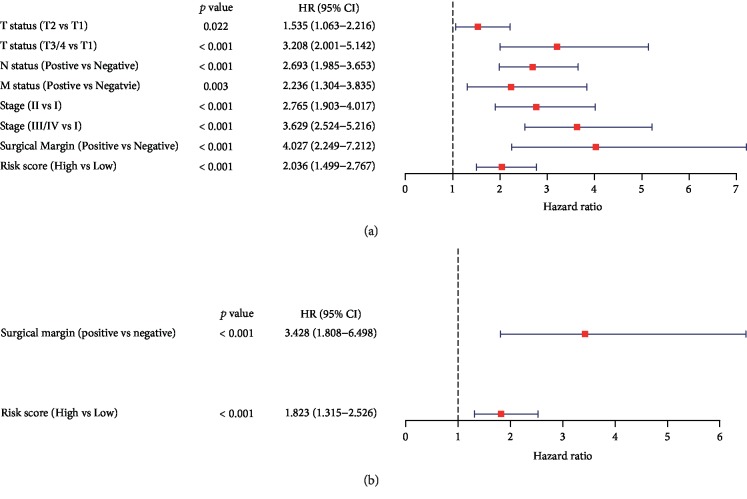
Forest plots of univariate and multivariate Cox regression analyses of risk factors associated with overall mortality in the TCGA LUAD cohort. (a) Forest plot of univariate Cox regression results. (b) Forest plot of multivariate Cox regression results.